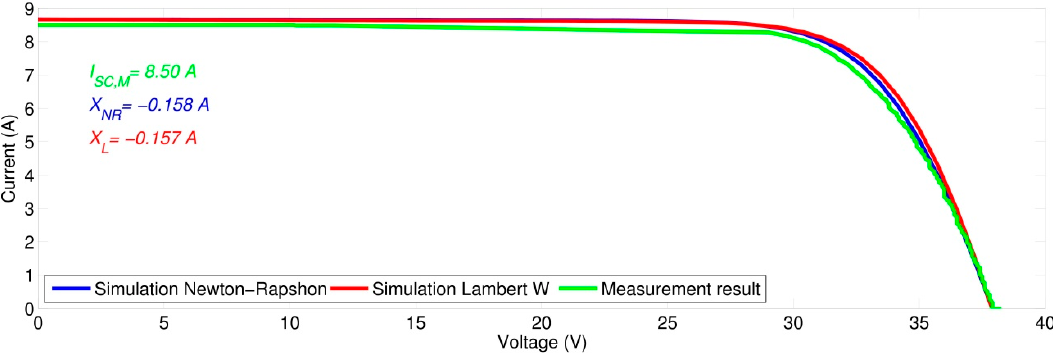
Figure 5. Comparison of measured I - V curve and simulation results.